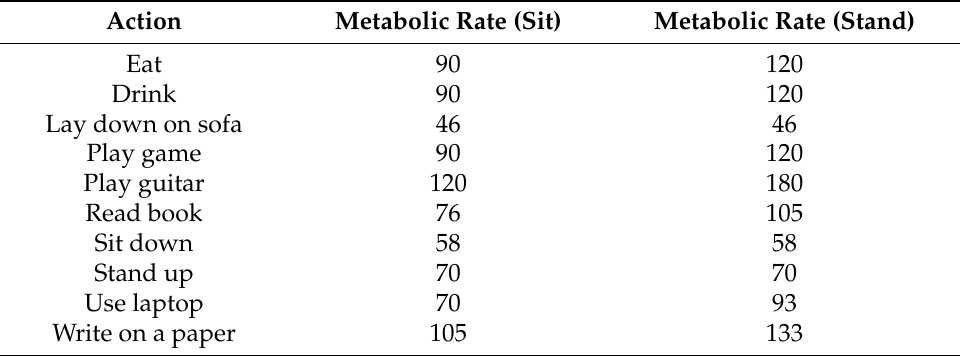
Table 1. A number of exemplar actions and the corresponding metabolic rates whilst sitting and standing